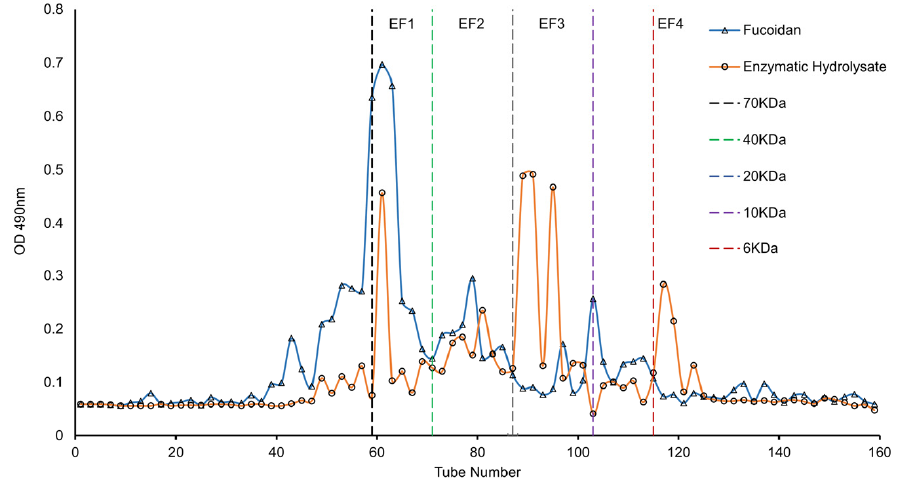
Figure 7. The elution curve of fucoidan and degradation products via Sephacryl-100 column chro- matography.